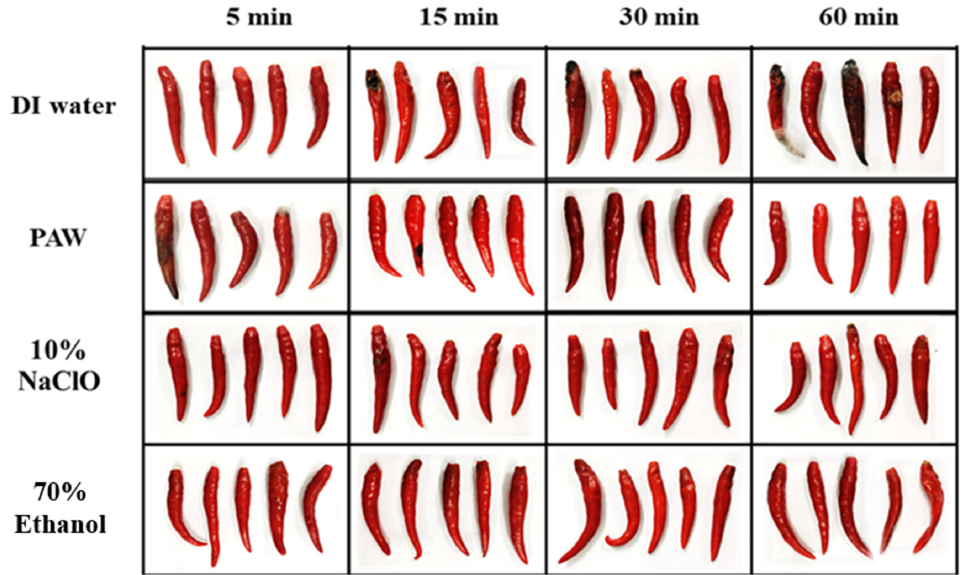
Figure 12. Disease control of Anthracnose in chili sample after treated by DI water, PAW, 10% NaClO, and 70% ethanol at 5, 15, 30, and 60 of treatment time.